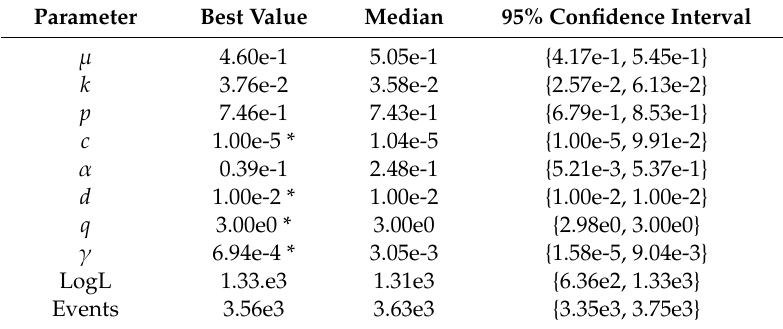
Table 7. Parameter estimates for North Africa. Estimation results for the eight parameters of the ETAS model, the log likelihood and the number of events for the North Africa conflict catalog. Estimates marked with a * are at, or very close to, their constraint values. The best estimate, that is, the estimate of the run with the highest log likelihood, is given for each parameter. Furthermore, the median and the 95% confidence intervals are given.